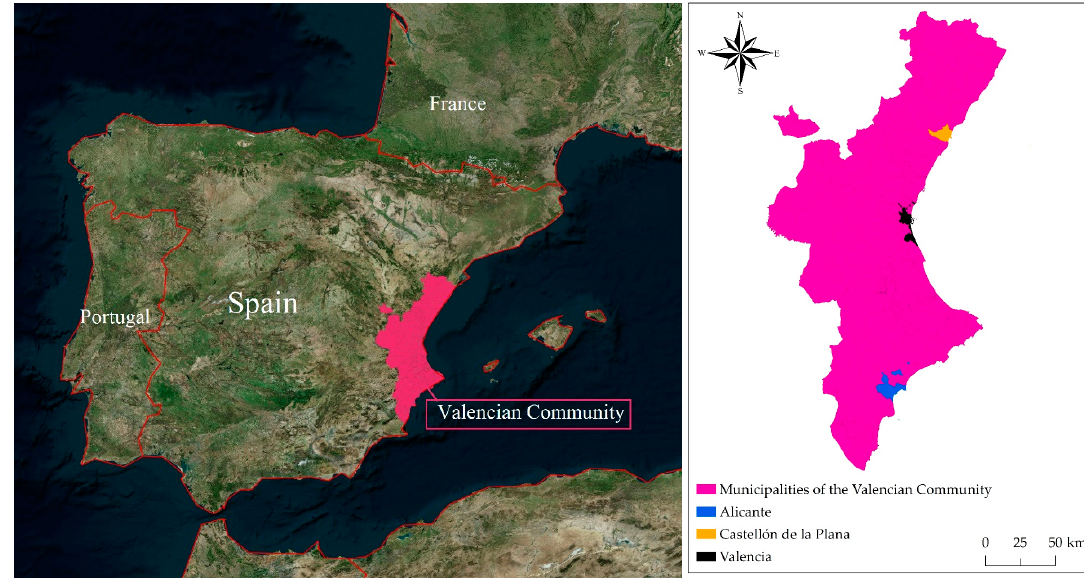
Figure 1. Territorial framework of the study area in Southwestern Mediterranean Europe. Source: Own elaboration.